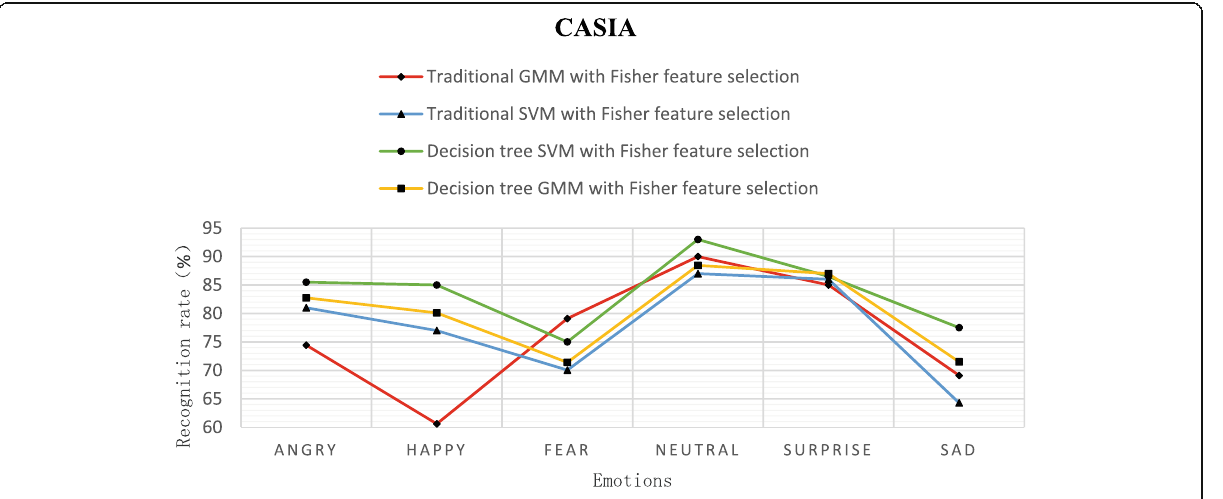
Fig. 5 Comparison of speech emotion recognition rates